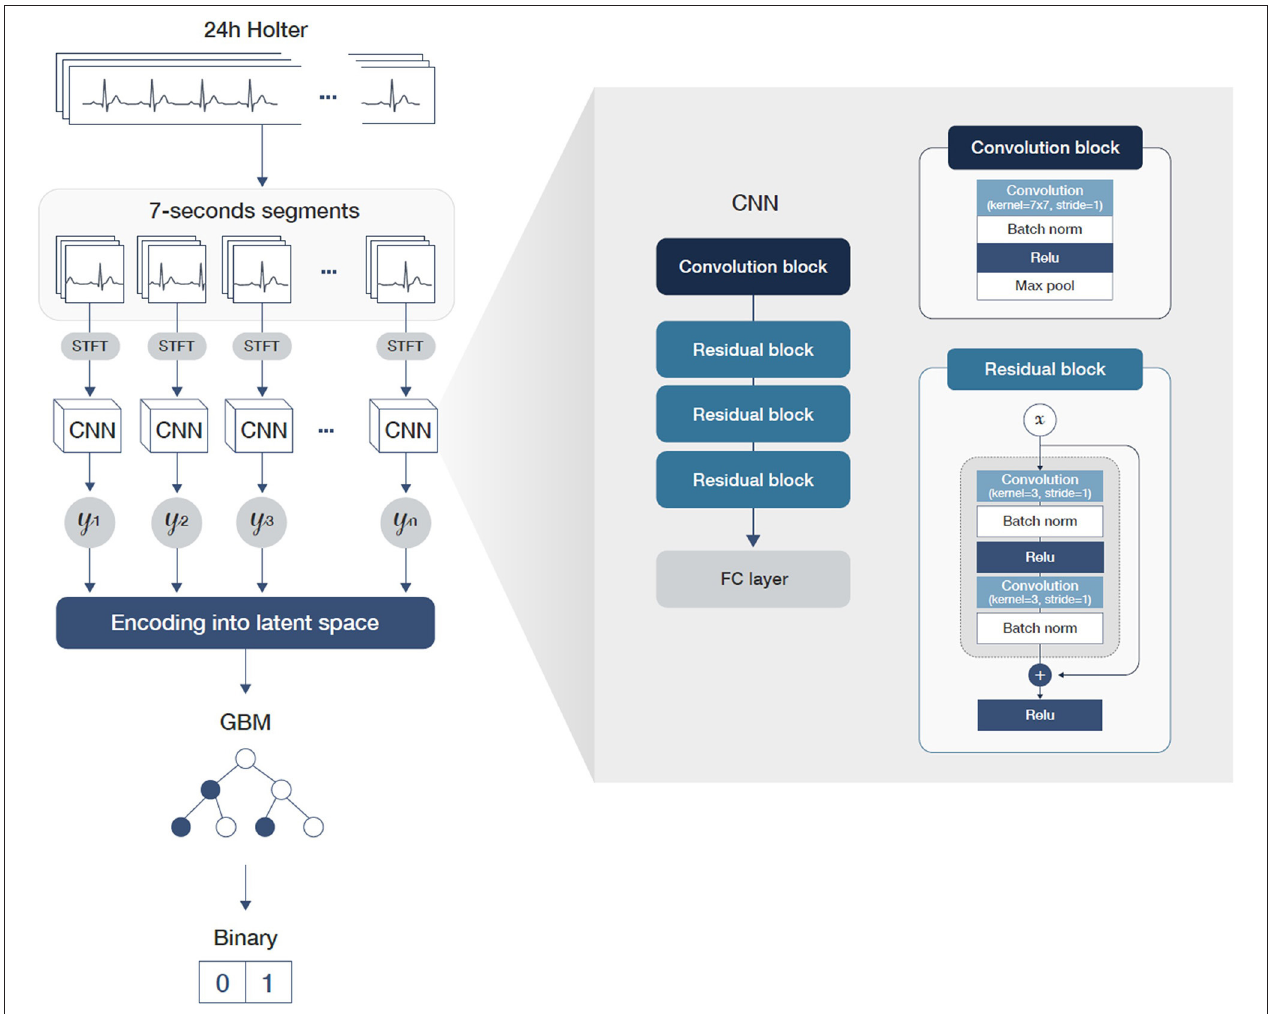
FIGURE 3 | A graphical workflow and architecture of the full model including detailed parameters of the convolution and residual